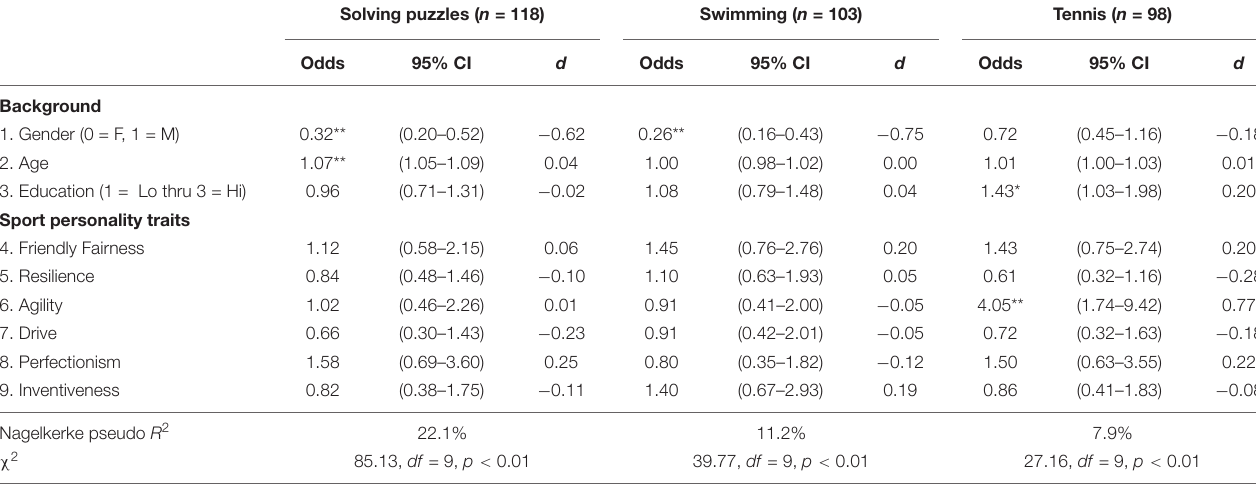
TABLE 5 | Logistic regression of the most practiced sports and leisure activities on background and sport personality traits ( N =